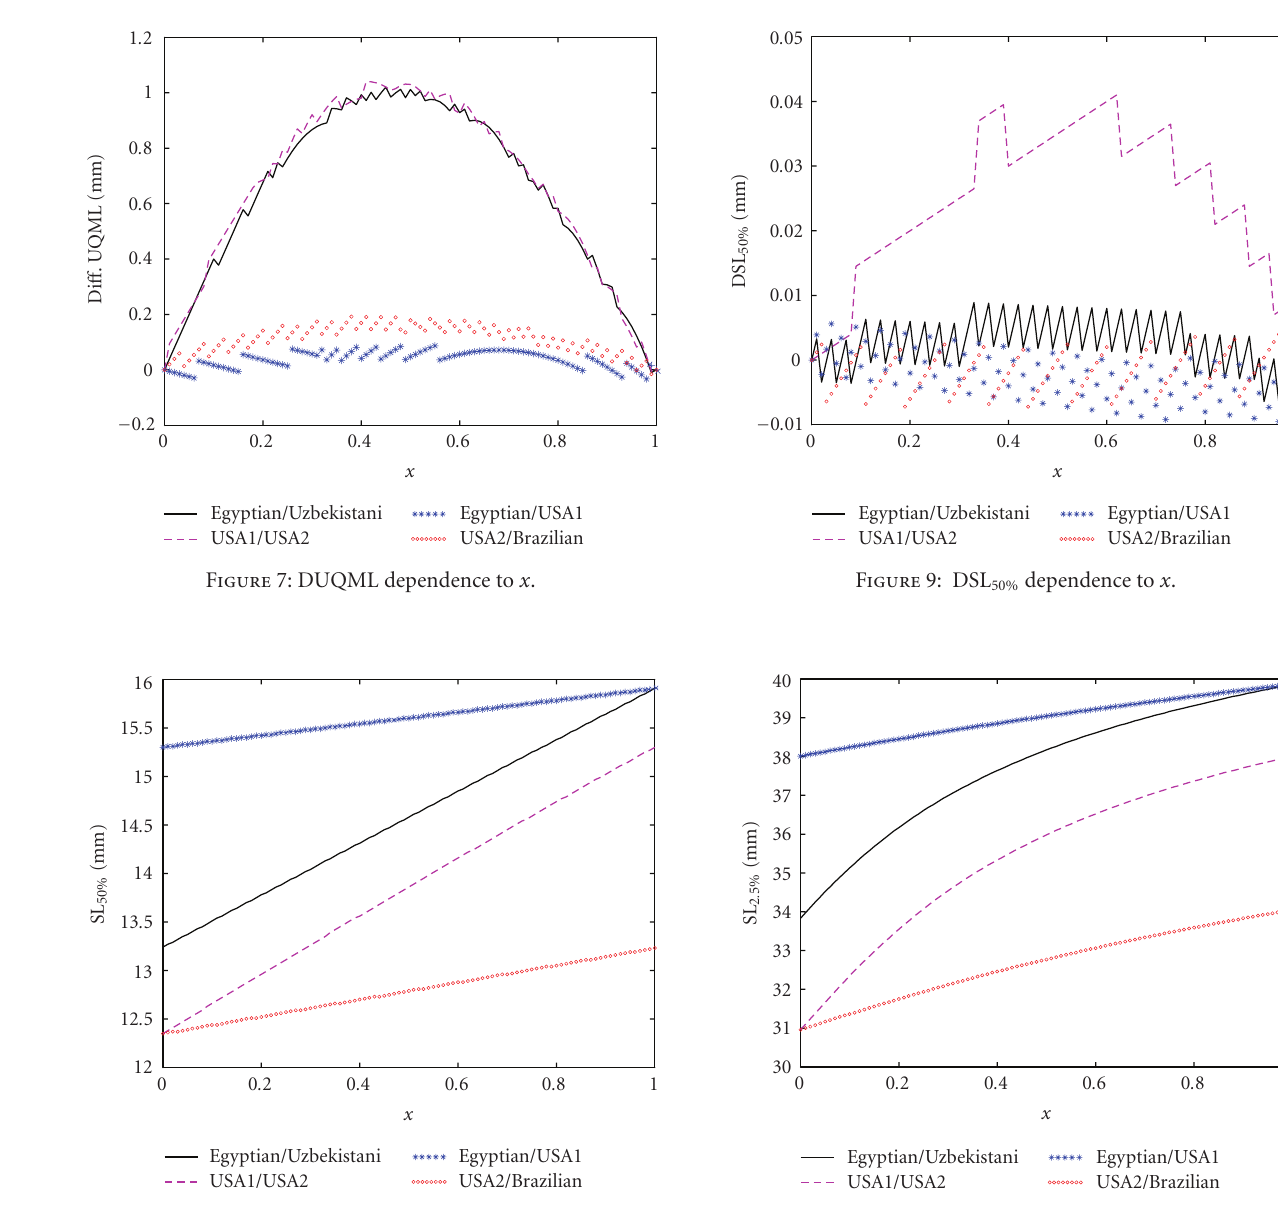
Figure 8: SL 50% dependence to x .